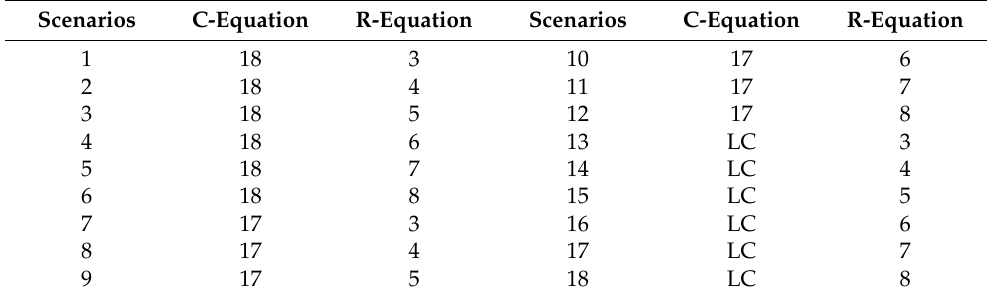
Table A1. The eighteen RUSLE scenarios of the R and C factors combinations were examined in Darbandikhan Lake for the period between November 1961 and 2 May 2022.